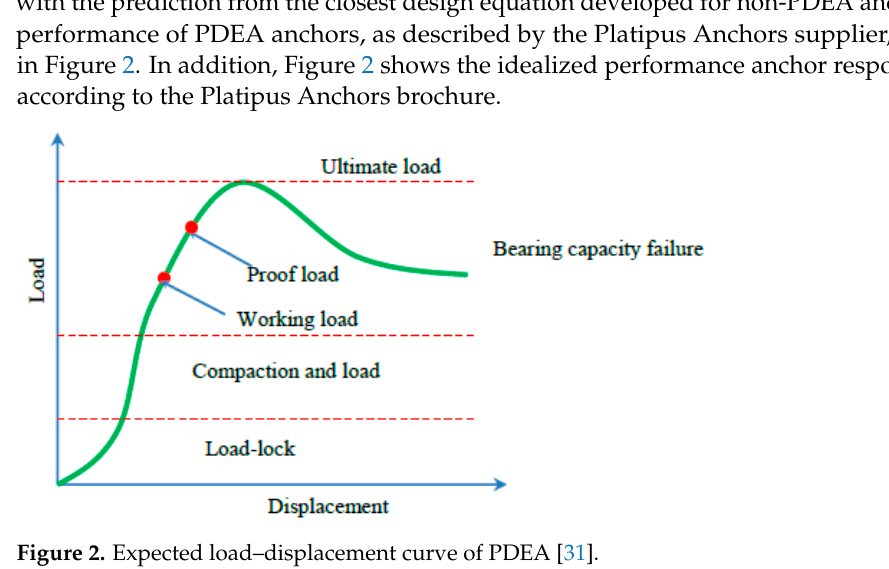
Figure 2. Expected load–displacement curve of PDEA [31].